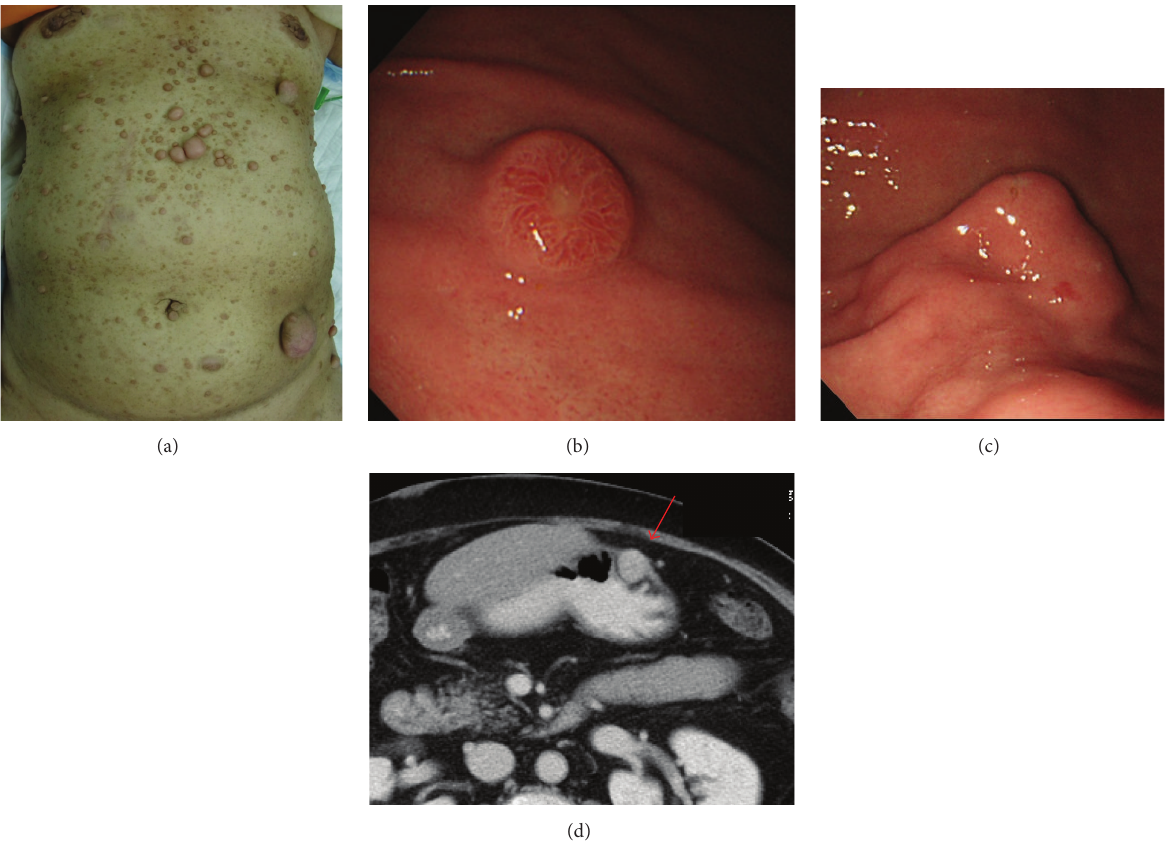
Figure 1: (a) There are multiple neurofibromas and some cafe-au-lait spots all over the body skin. (b) Upper gastrointestinal endoscopy shows neuroendocrine tumor located on posterior side of upper gastric wall. The size was about 10mm. (c) And submucosal tumor located on greater curvature side of middle gastric wall. The size was about 30 mm. (d) Computed tomography showed only a SMT (arrow); the size was about 30 mm and the surface was smooth. Other lesions could not be pointed out.